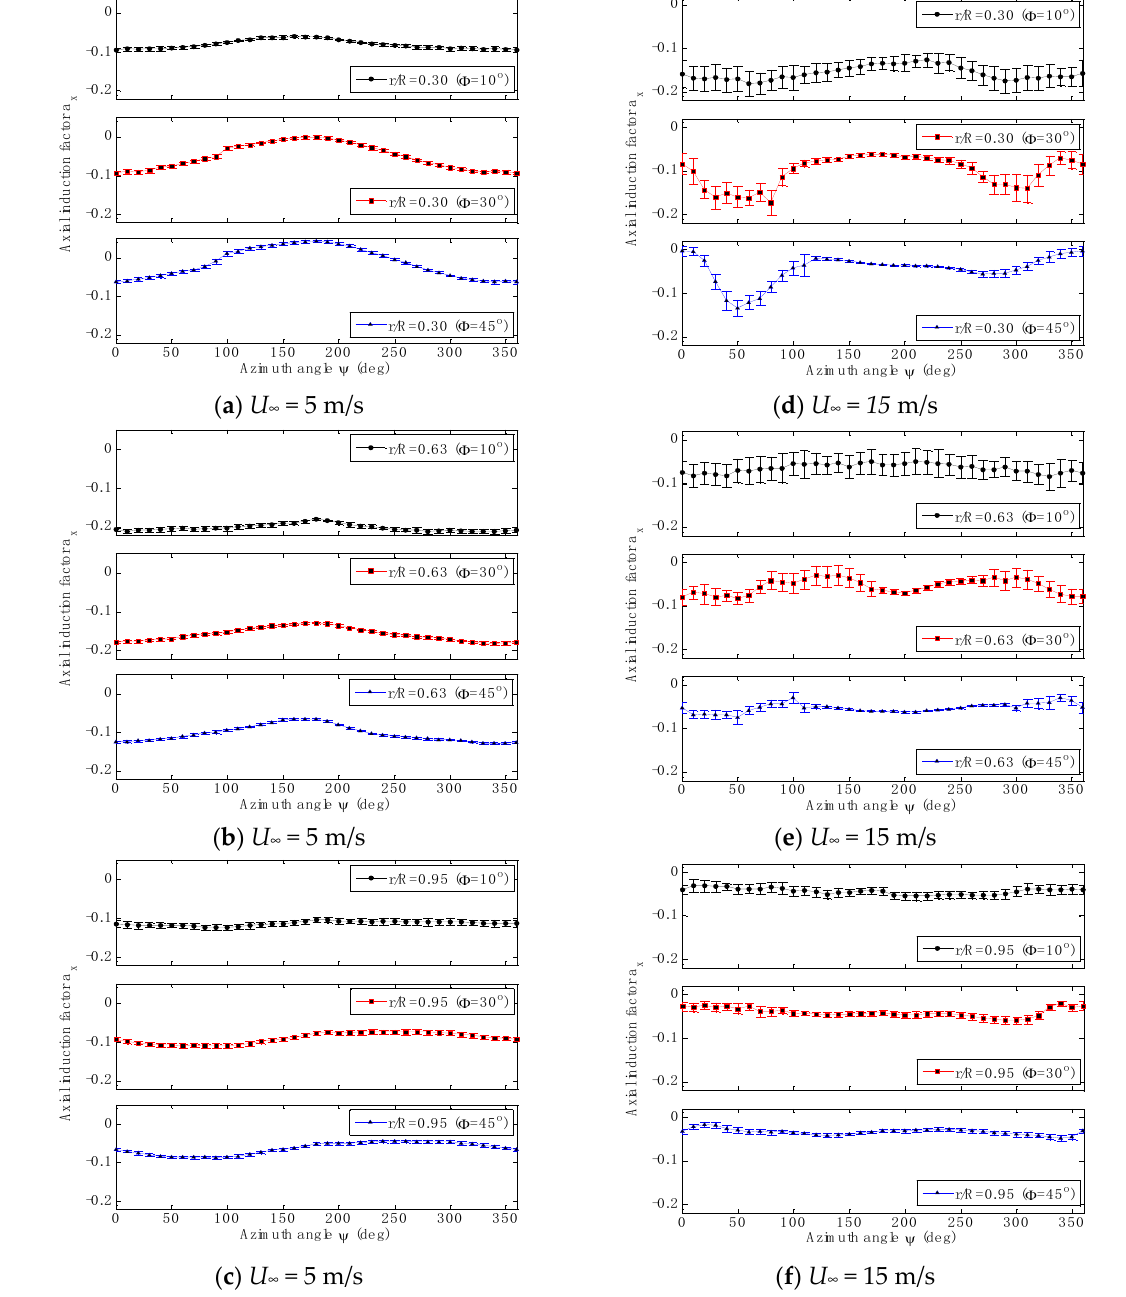
Figure 8. Variation of the unsteady axial induction factor against the blade azimuth angle at different radial locations and yaw angles at wind speeds of 5 and 15 m/s.